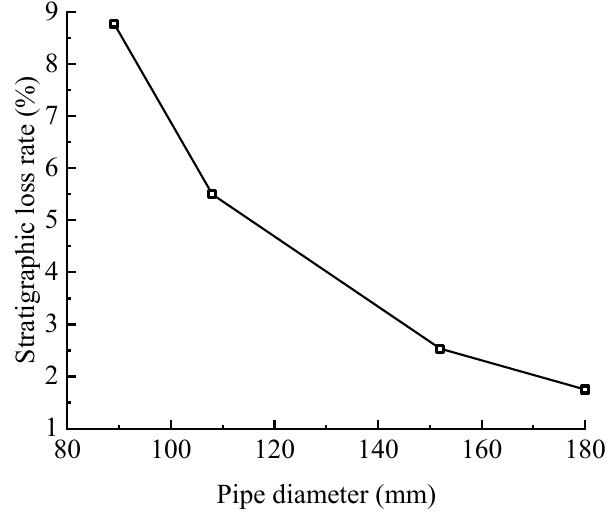
deformation, it is not economical to consider increasing the diameter of the steel pipe.